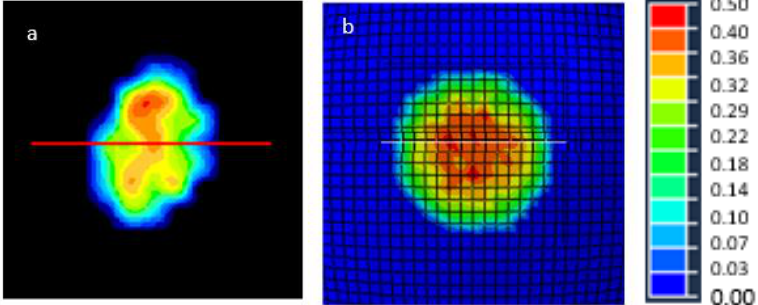
Figure 13. Layers and surface pressure distributions of the real object ( a ) and model object ( b ) for an apple dropped from a height of 10 mm on a concrete substrate in a section passing through the central point of contact.